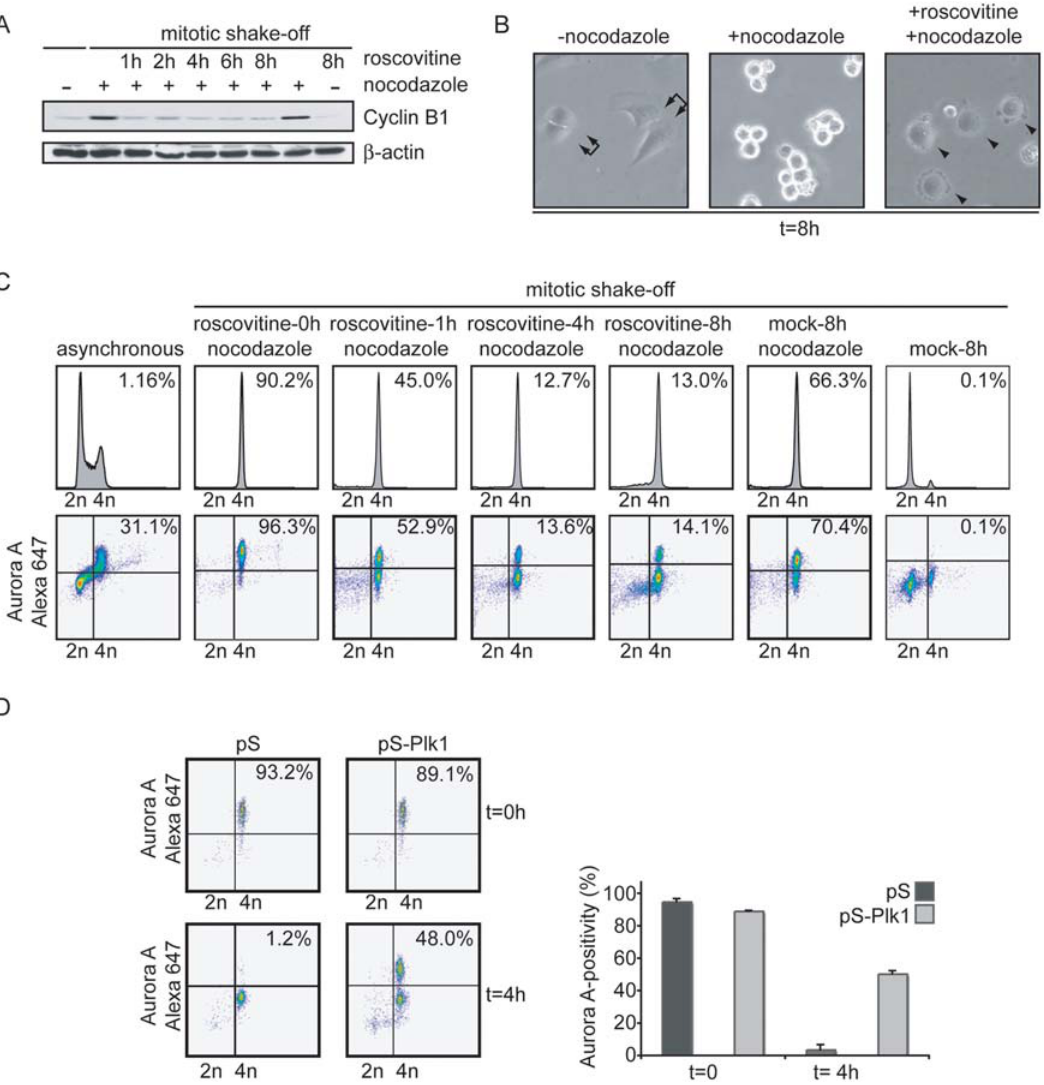
Figure 3. Aurora A degradation during synchronized mitotic exit. A, B, C U2OS cells were treated with nocodazole for 16 hours. Mitotic cells were collected by mitotic shake off and left untreated or treated with Roscovitine. At indicated time points after Roscovitine addition, cell lysates were obtained (A), DIC images were takes (B) or cells were fixed in ethanol for FACS analysis (C). Cell lysates were analyzed by Western blotting using anti-Cyclin B1 and anti- b -Actin (A). In parallel, cells were co-stained with anti-Aurora A-Alexa 674 and anti-MPM-2-Alexa 488 and analyzed by FACS. MPM2-positivity of 1*10 4 events is indicated in upper-right corner of DNA profile histograms. Aurora A-positivity is indicated in upper right corner of Aurora A plots. D. U2OS cells were transfected with pS or pS-Plk1 in combination with GFP-spectrin. 36 h after transfection, nocodazole was added to cell cultures. After 16 h, mitotic cells were collected by shake-off. Mitotic cells were replated in the absence or presence of Roscovitine for 4 h, and subsequently cell were fixed in ethanol and stained with anti-Aurora A-Alexa-647. Representative Aurora A-plots of GFP-positive cells are shown (left panel) and the mean and SEM of 3 experiments are plotted (right panel).